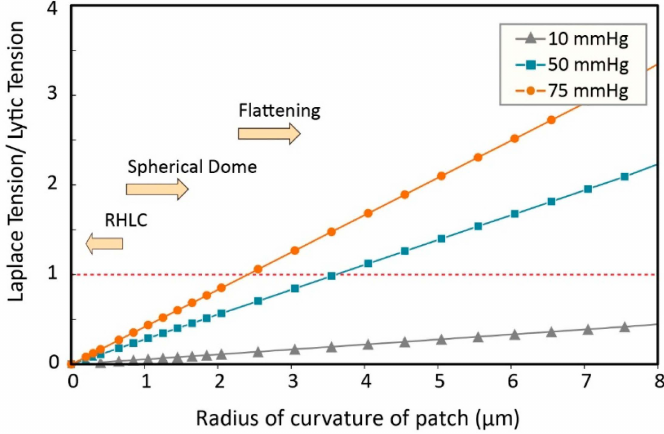
Figure 5. The effect of the radius of curvature on ratio of the distributed tension and the lytic tension. By decreasing the radius of curvature to the RHLC (Region of High Local Curvature), the calculated tension using the simplified form of the Laplace’s law approaches zero. This implies that all of the channels in RHLC don’t sense the membrane tension produced by the applied negative